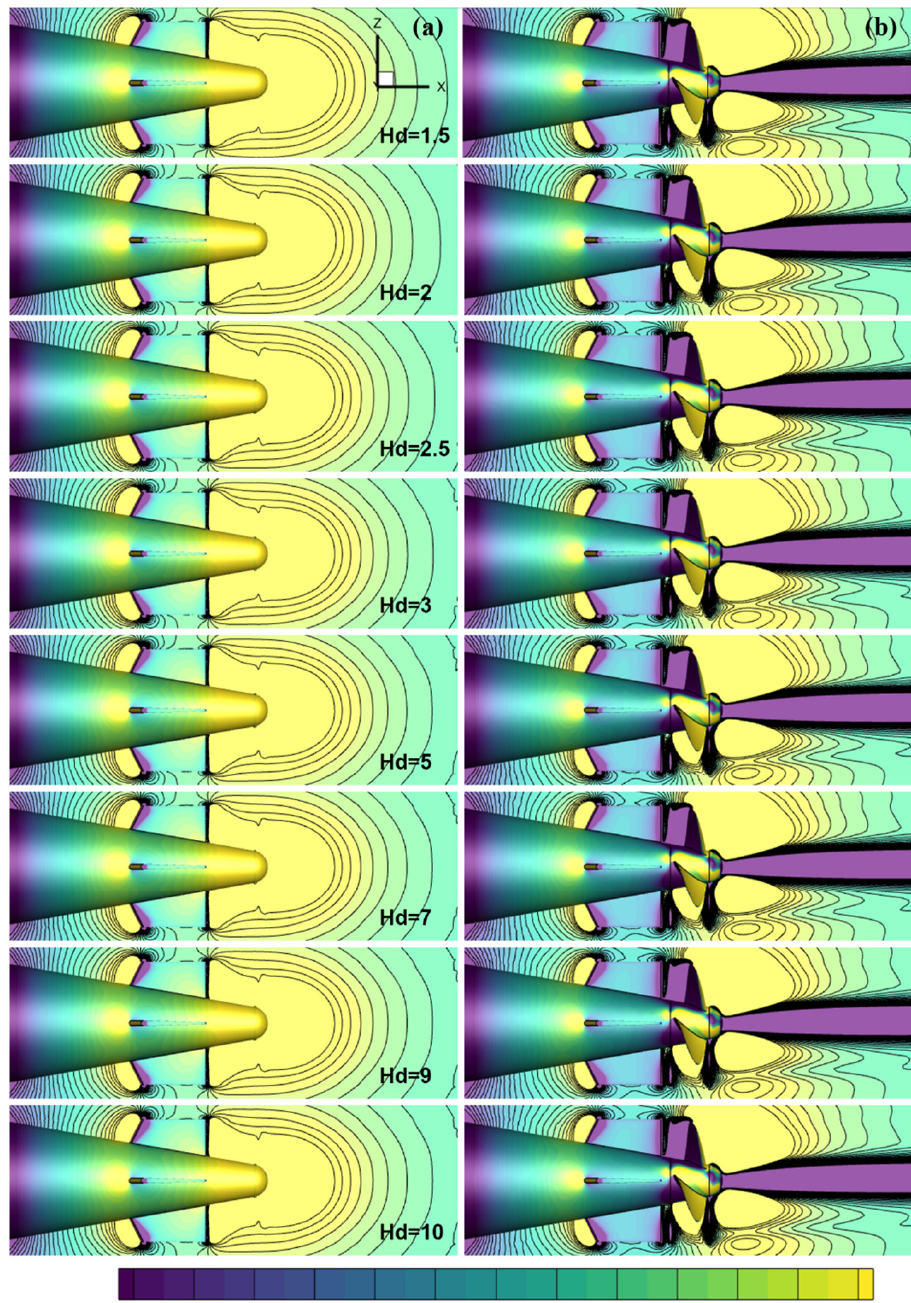
Figure 16. The pressure clouds at the bare UUV as shown columns ( a ) and self-propelled UUV as shown columns ( b ) at a cross-section.